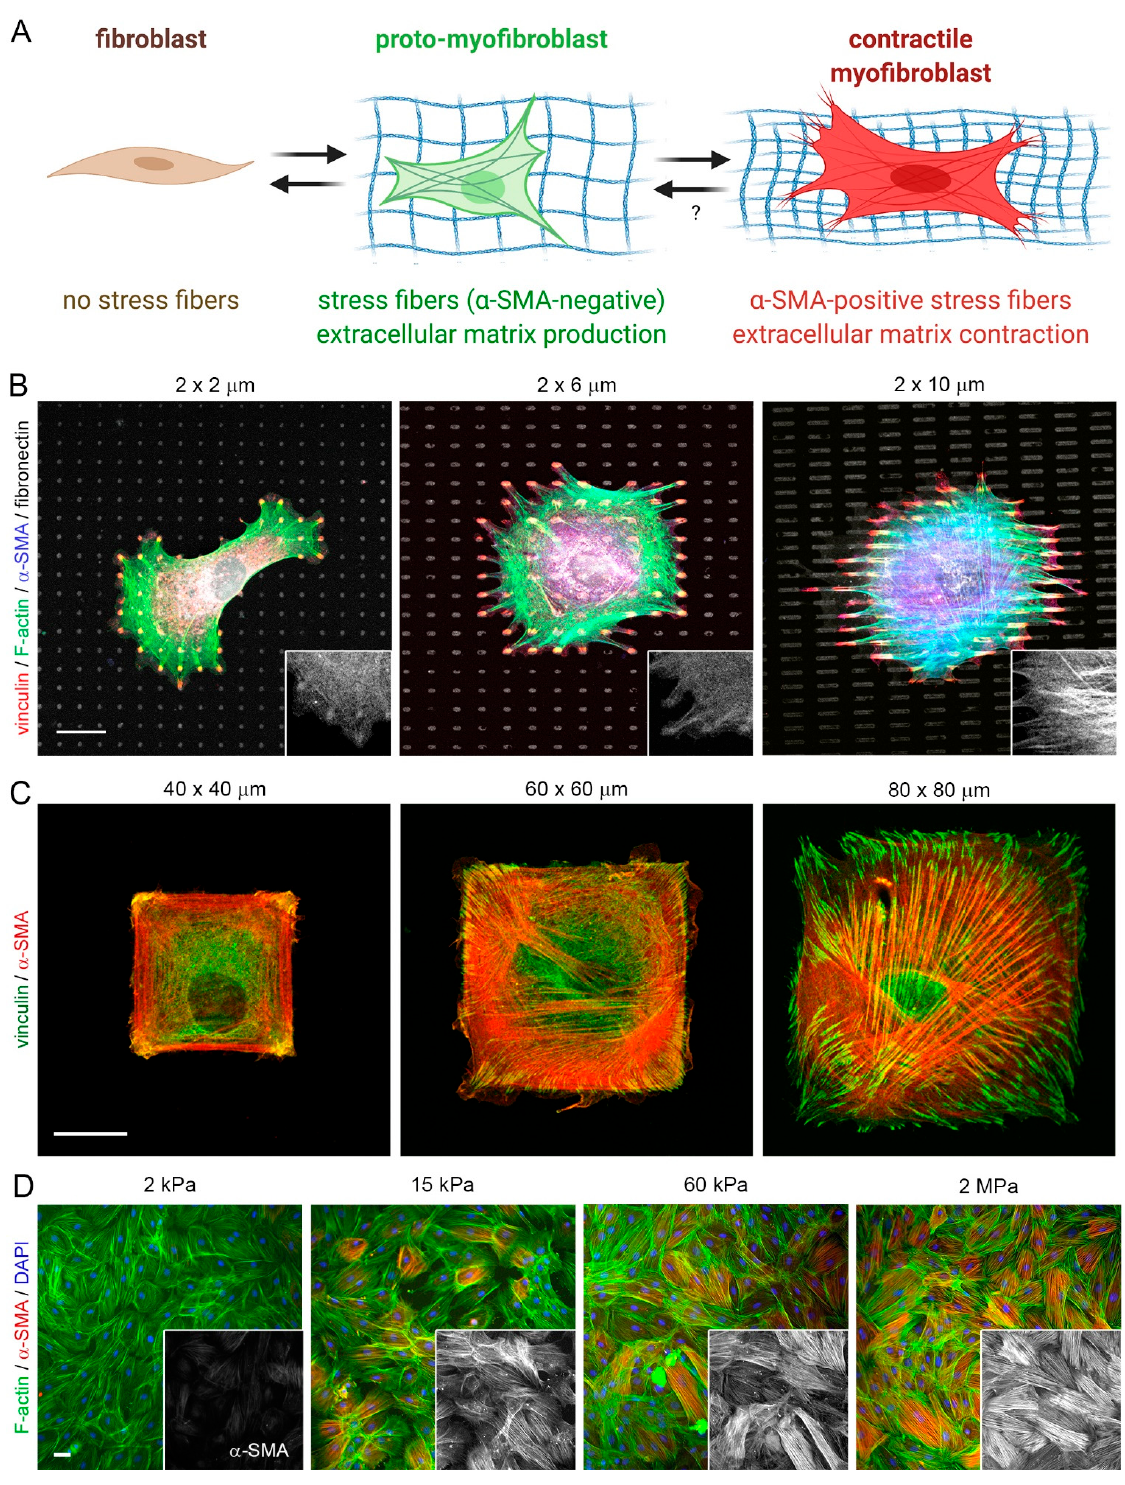
Figure 4. Control of fibroblast-to-myofibroblast activation by adhesion patterns and substrate stiffness. ( A ) Activation of non-contractile (‘quiescent’) tissue fibroblasts into highly contractile, α -SMA stress fiber forming myofibroblasts passes over consecutive activation stages, one of which is characterized by α -SMA-negative stress fibers. This so-called pro-myofibroblast produces extracellular matrix and is the prevalent fibroblast phenotype in conventional cell culture. Myofibroblast activation stages can be controlled in culture by altering substrate adhesion patterns or stiffness. ( B – D ) Myofibroblasts from